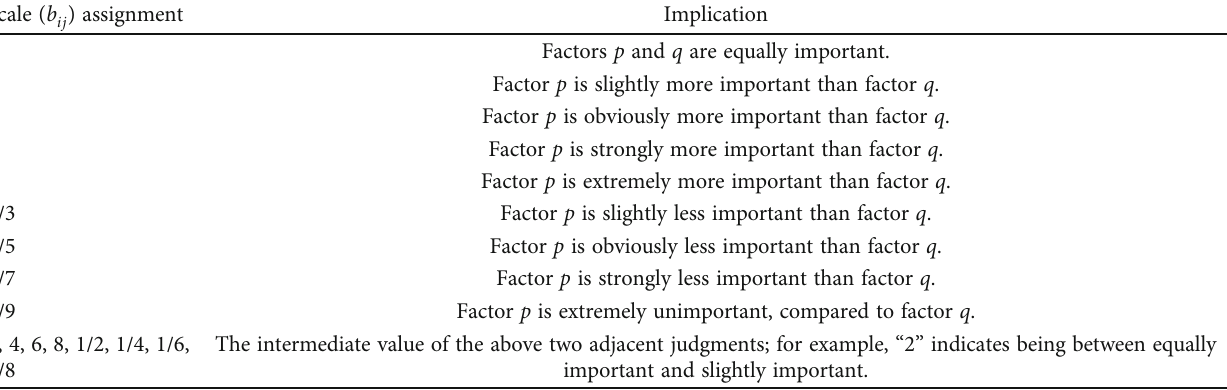
Table 1: Evaluation criteria of relative importance between pairs of factors ( p , q ) and their assignments [35]. Scale ( b ij ) assignment Implication Factors p and q are equally important. Factor p is slightly more important than factor q